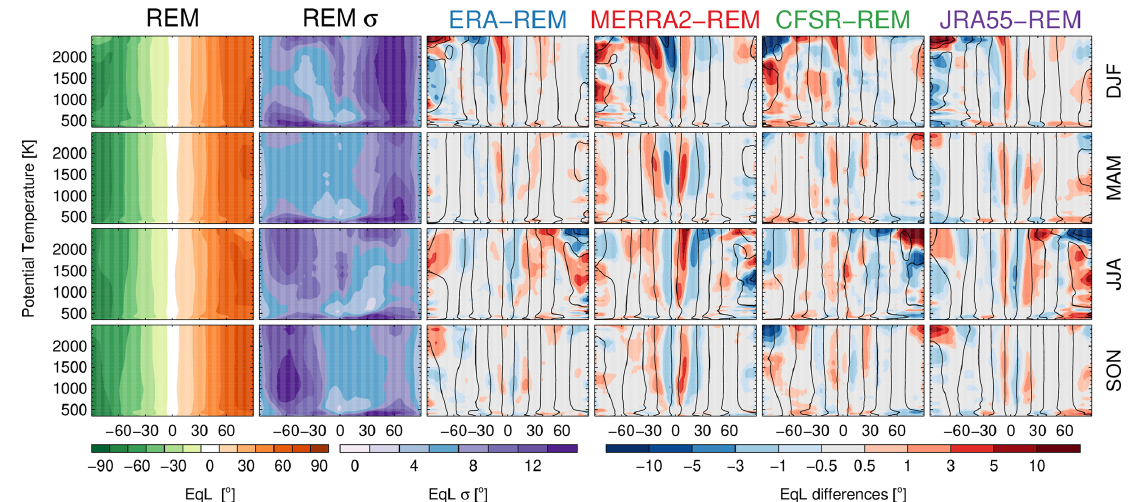
Figure 6. Equivalent latitude REM seasonal climatological mean and standard deviation for different seasons (left two columns). Equiv- alent latitude difference between each reanalysis and the REM (right columns). Overlaid contours show each reanalysis fields respective